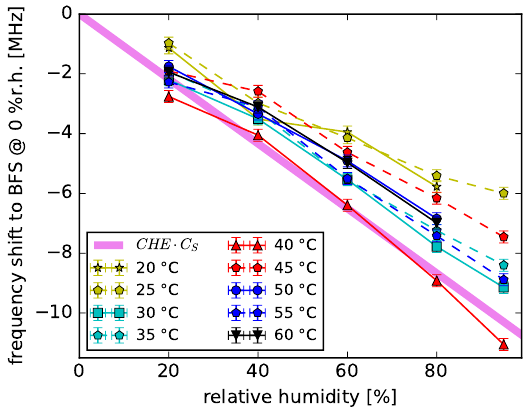
Figure 7. BFS as a function of relative humidity at specified temperatures. The BFS is given as a difference to the theoretical BFS at each corresponding temperature and 0